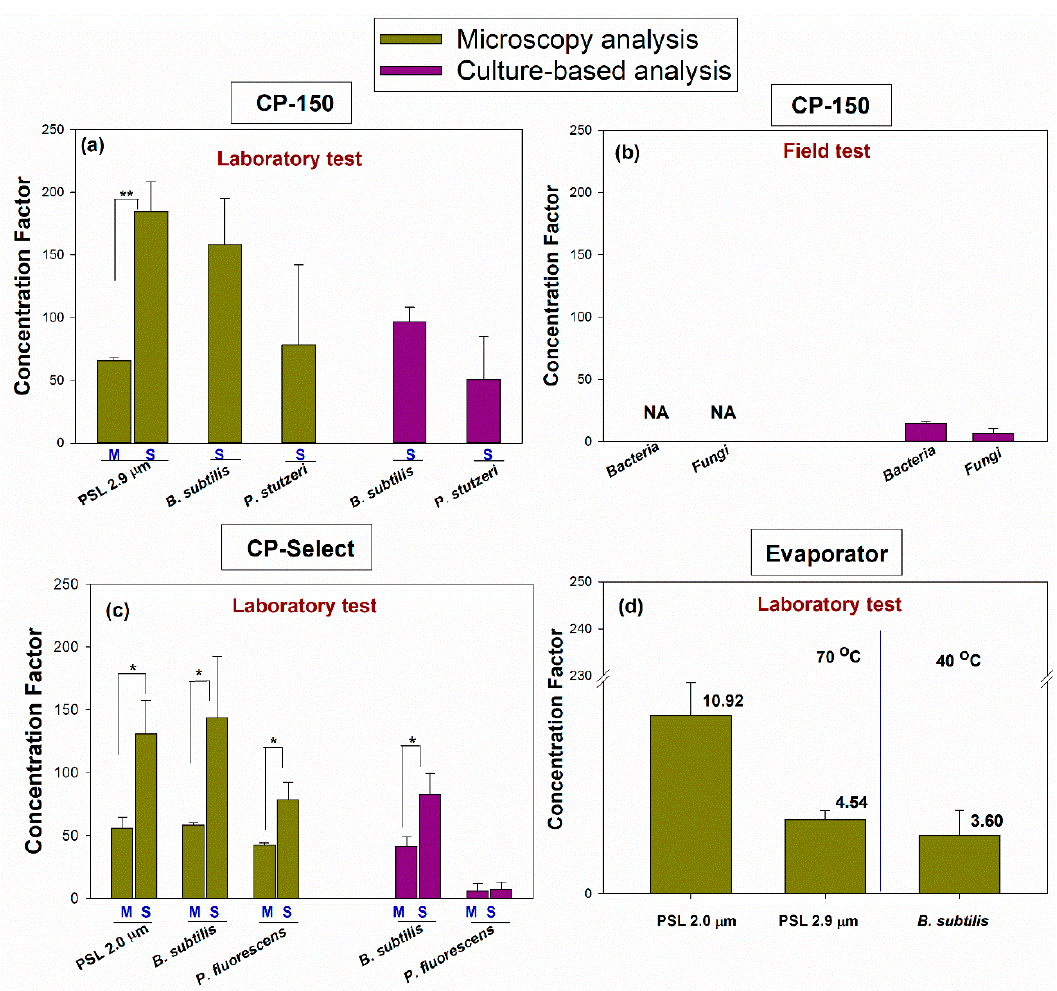
Figure 7. Concentration factor (CF) of the concentrators when operated with the di ff erent particles and at di ff erent instrument settings. The CP-150 was also used to concentrate the field samples. Symbols M and S in the figure represent the medium and small final suspension volumes. The data represent the averages of three repeats, and the error bars represent one standard deviation. ( a ) and ( b ): laboratory and field test using CP-150, respectively; ( c ): laboratory test using CP-Select; ( d ): laboratory test using BioChromato Evaporator.